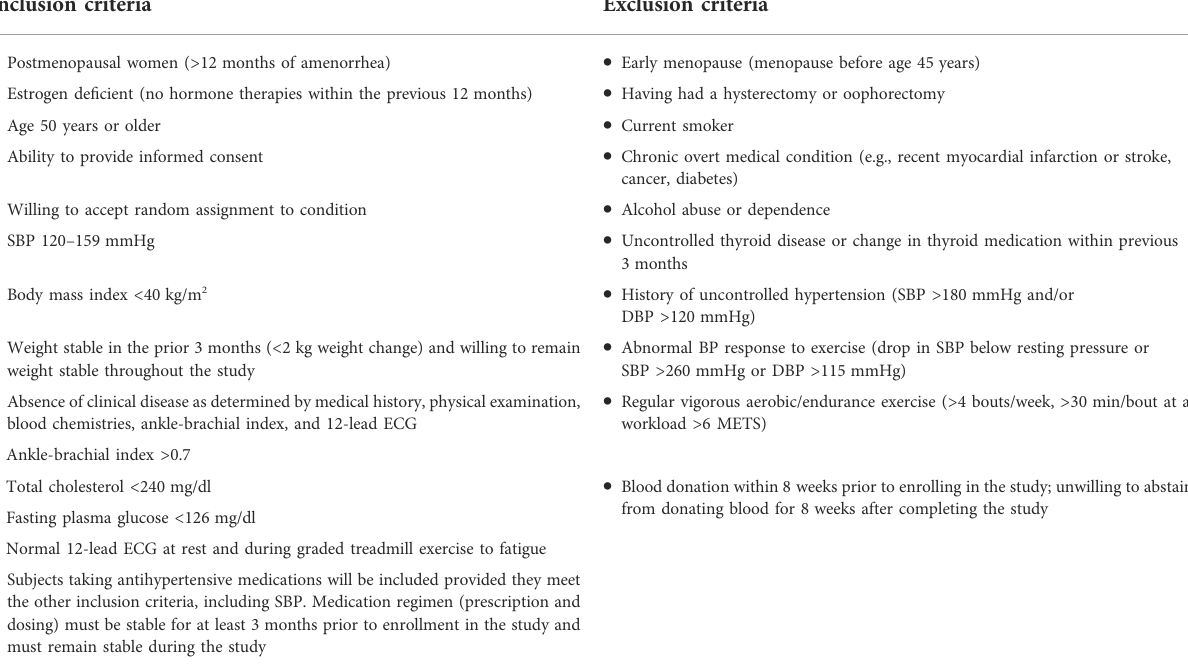
TABLE 1 | Inclusion and exclusion